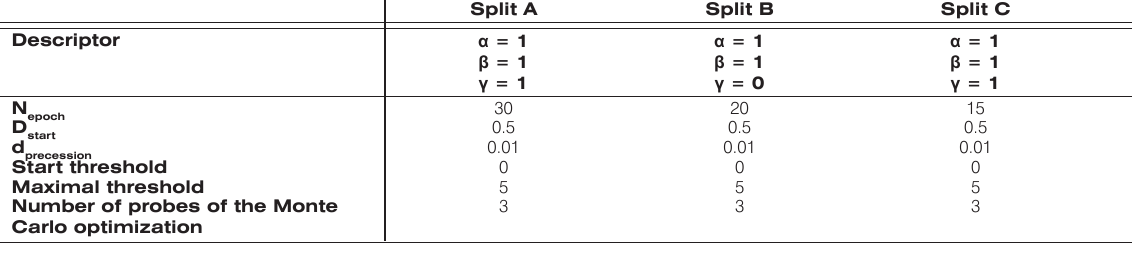
Table 1. Options used in the CORAL calculations for split A, split B, and split C. The classic scheme (i.e., training – validation